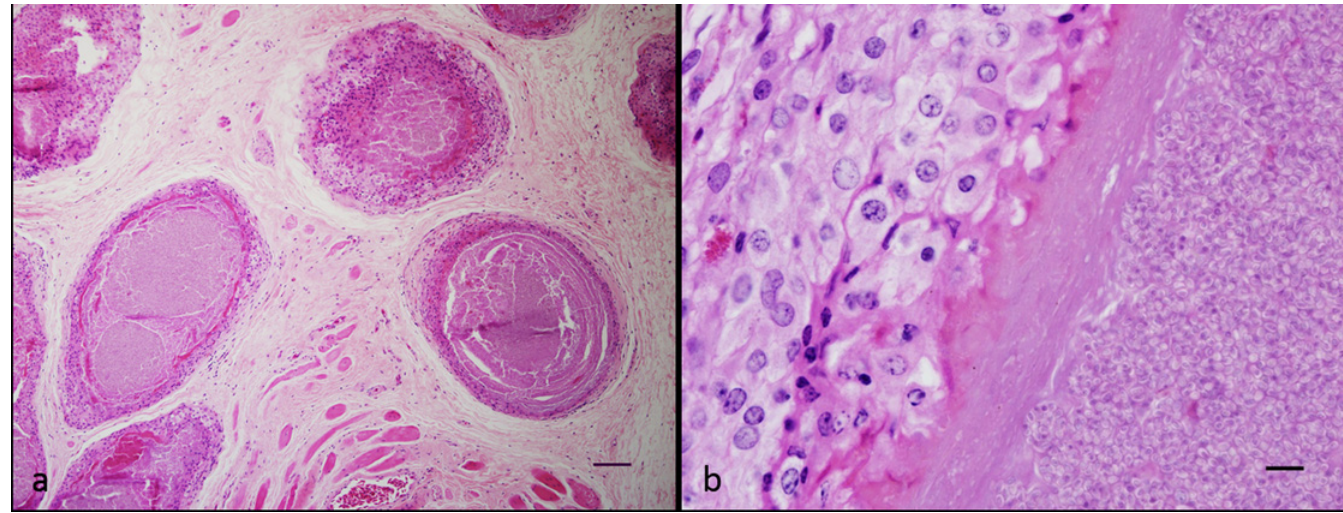
Fig 2. Histopathology of sea snake microsporidia a) Dense aggregates of microsporidian spores scattered throughout skeletal muscle and subcutaneous adipose tissue. Snake HM2. Scale bar 100 μ m b) Spore aggregates were surrounded by a mantle of macrophages and enclosed within a delicate fibrous capsule. Snake HM2. Scale bar 10 μ